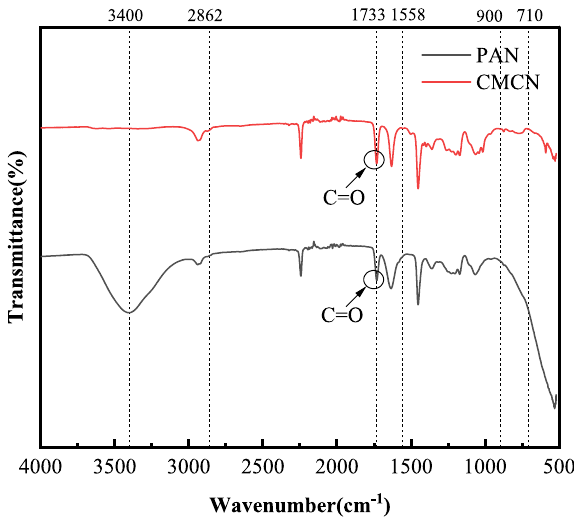
Figure 7. FTIR spectra of PAN and CMKN.